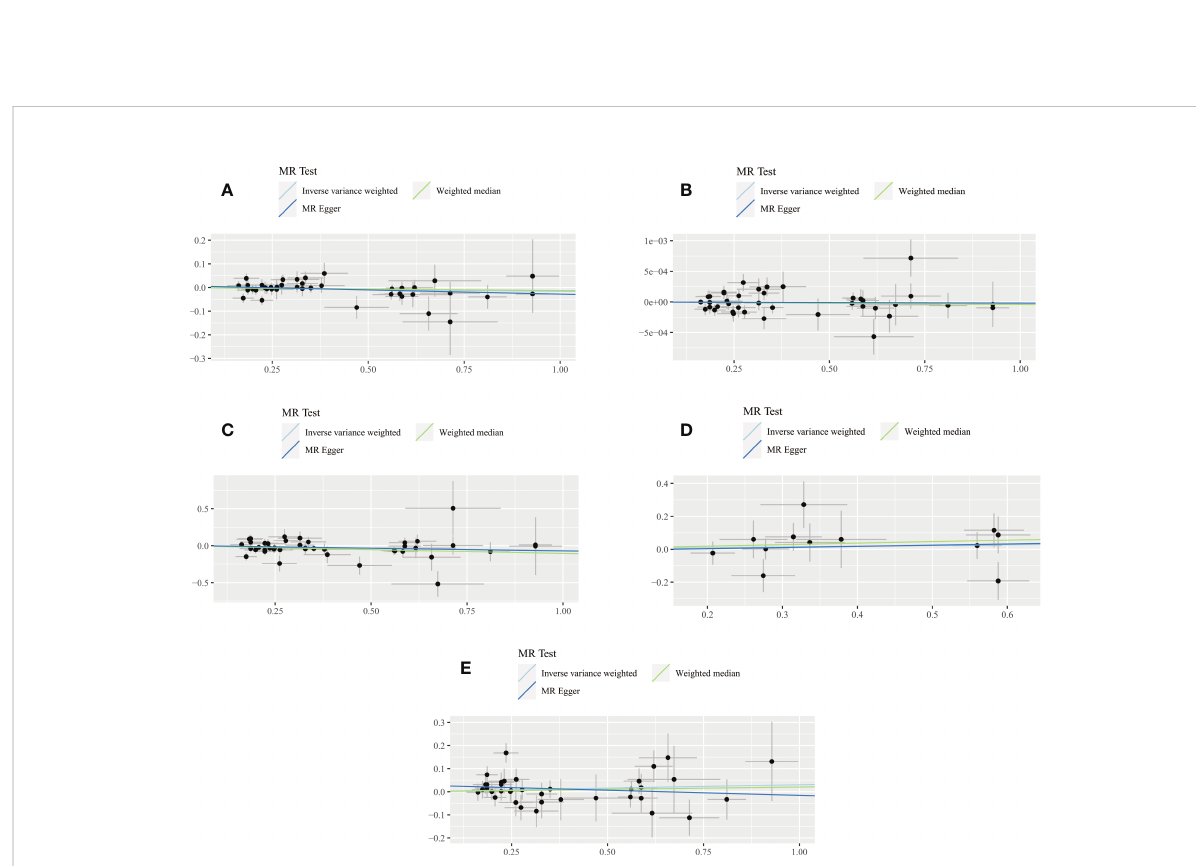
FIGURE 4 Scatter plot of the association between SLE and all dementia (A) , Alzheimer ’ s disease (B) , vascular dementia (C) , frontotemporal dementia (D) , dementia with lewy body (E) . Three lines reveal the estimated effect sizes by MR methods (inverse ‐ variance weighted, MR-Egger and weighted